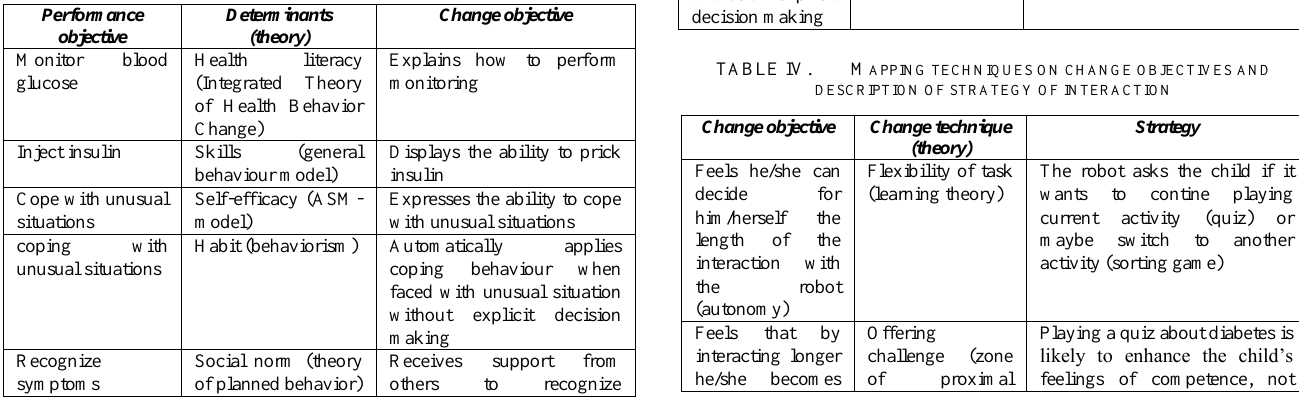
C HANGE OBJECTIVE MATRIX FOR INTERVENTION Performance objective